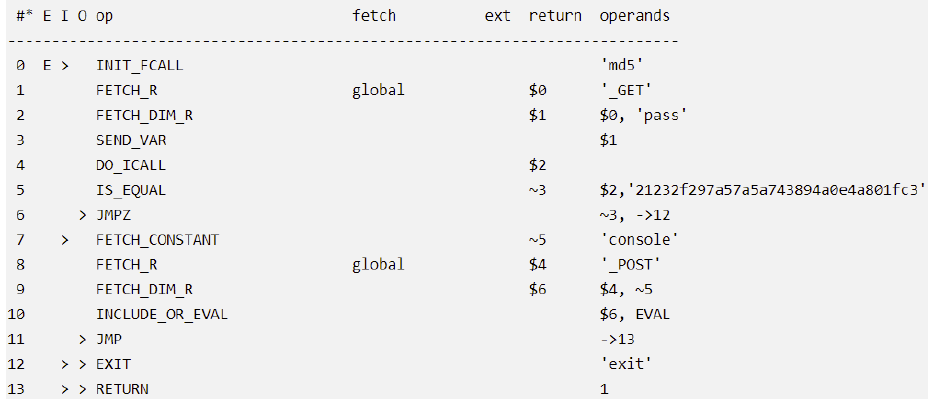
Figure 5. The Opline sequences of